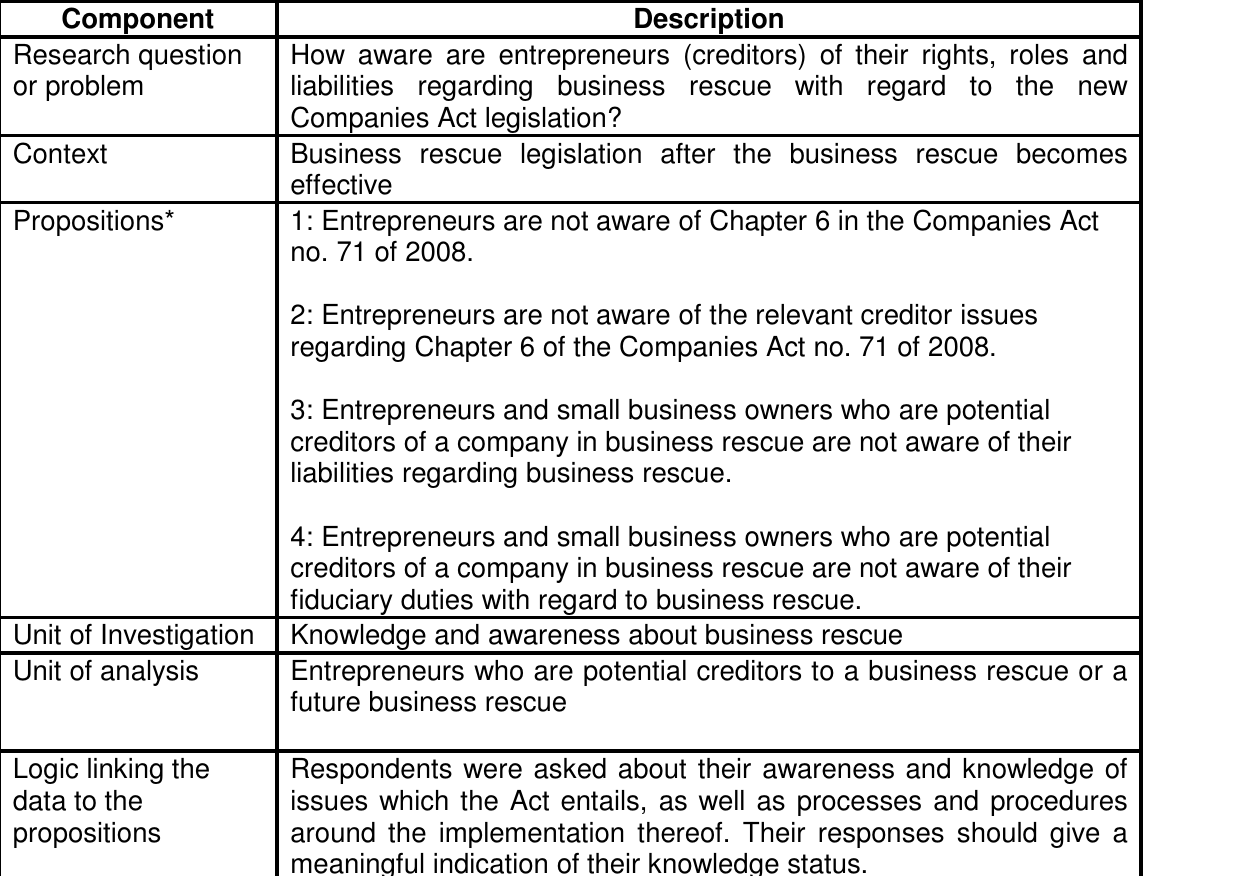
Table 2: Research design components